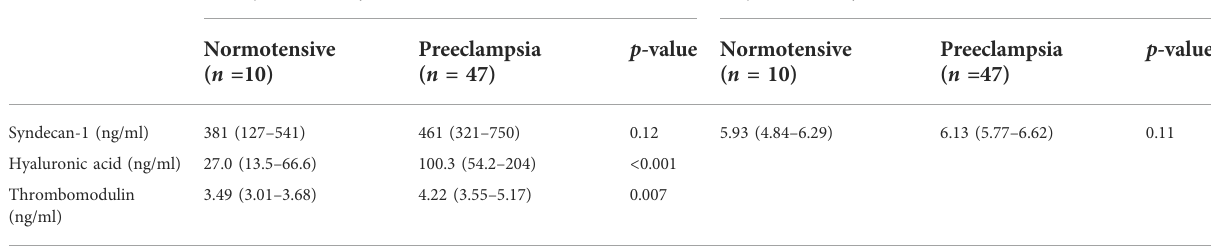
TABLE 2 Results: Normotensive vs.